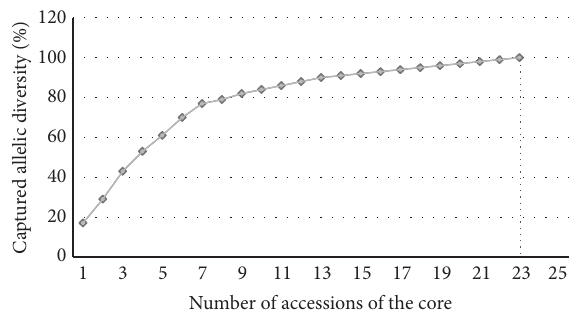
Figure4:Geneticdiversityasafunctionofthenumberofaccessions included in the Italian olive germplasm core